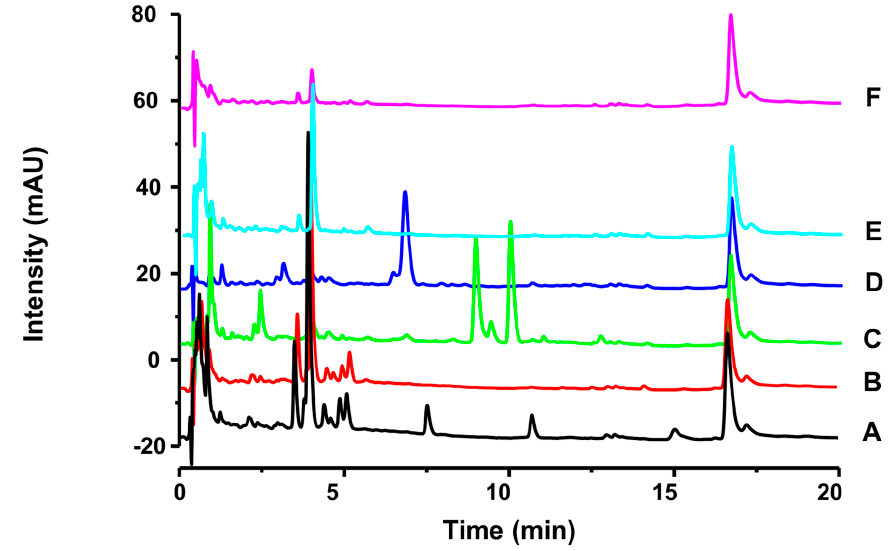
Figure 1. UHPLC-DAD chromatogram of G. americana leaf extract and fractions. Solvent system: mix of acetonitrile: water (with 0.3% of acetic acid); Flow rate: 0.3 mL/min; Software LC Solution ; Wavelength: 254 nm. column C 18 Shim-pack XR-ODS (Shimadzu ® , Japan) (30 × 2 mm, 2.2 µm), the temperature 25 ± 2 °C. A : EtOAc fraction; B : n- BuOH fraction; C : CHCl 3 fraction; D : PE fraction; E : Aqueous residual fraction; F : Extract